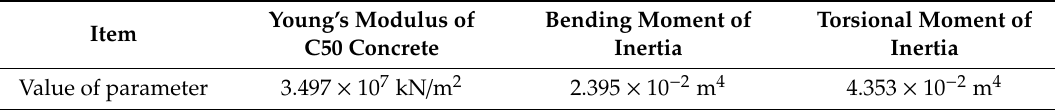
Table 1. Parameters used for the finite element model of the simply supported bridge.